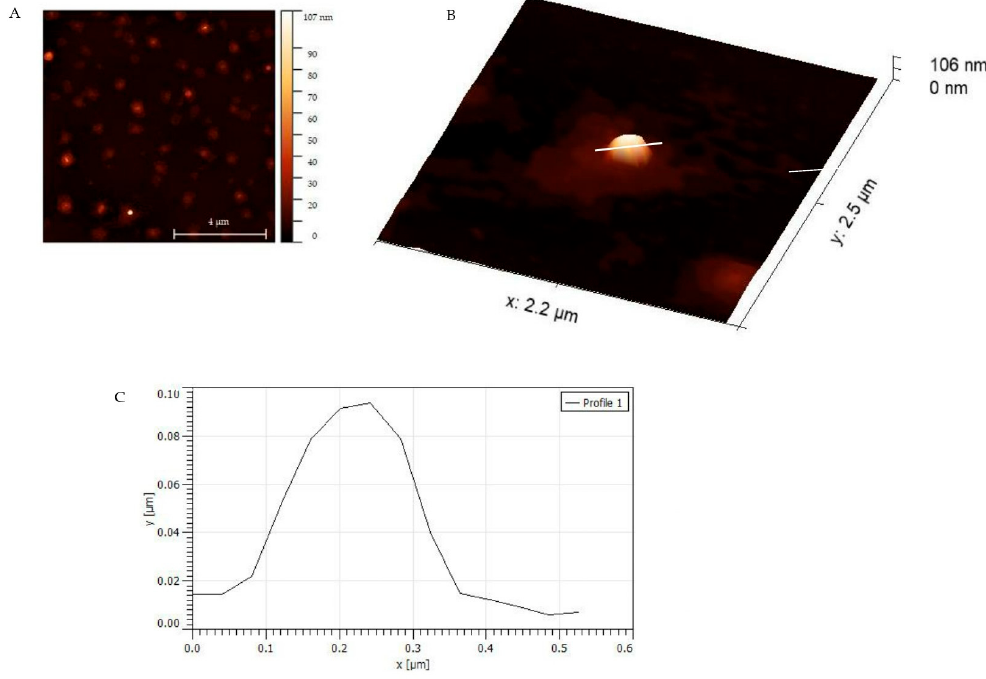
Figure 4. AFM characterization of MIP nanoparticles; ( A , B ) are AFM height images of MIP nano- particles at a different scale have sizes around 70–107 nm. ( C ). Topographic profile obtained from height image of AFM .